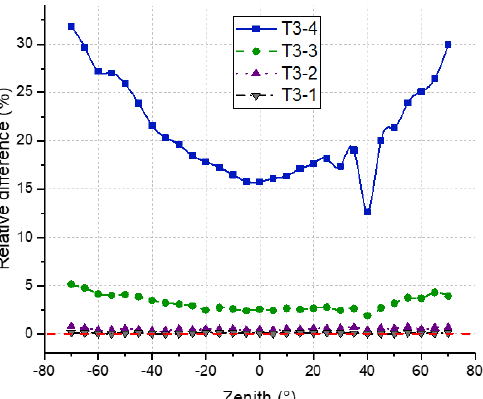
Figure 20. Relative difference in the NIR region (850 nm) for the third stage of growth ( a ) single scattering, ( b ) multiple scattering).